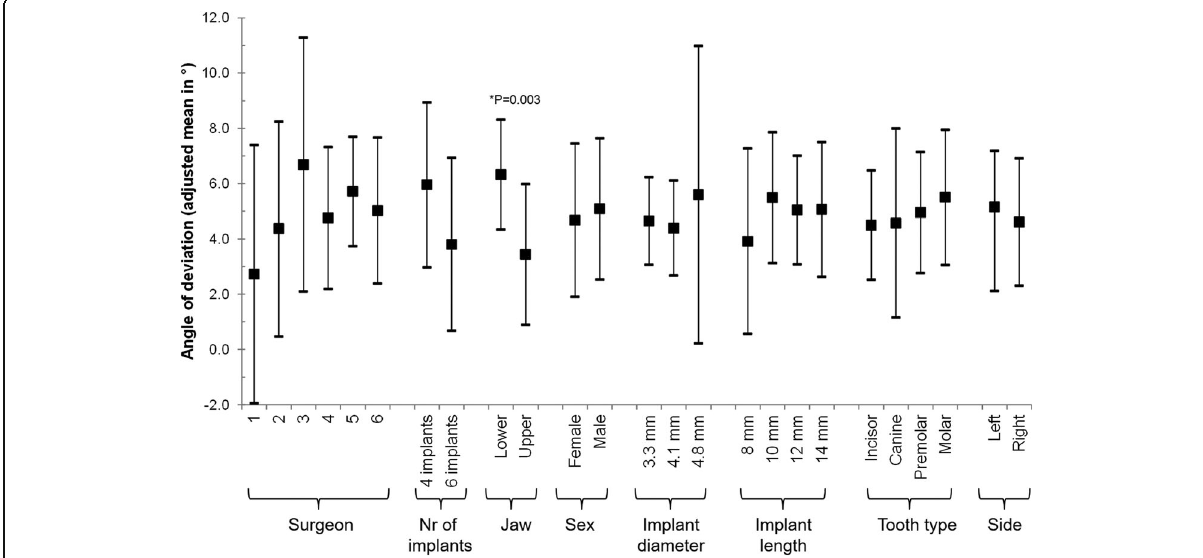
Fig. 4 Multivariable association between angle of deviation and all considered risk factors. A mixed regression model was used. The effect of the patient was introduced in the model as a random